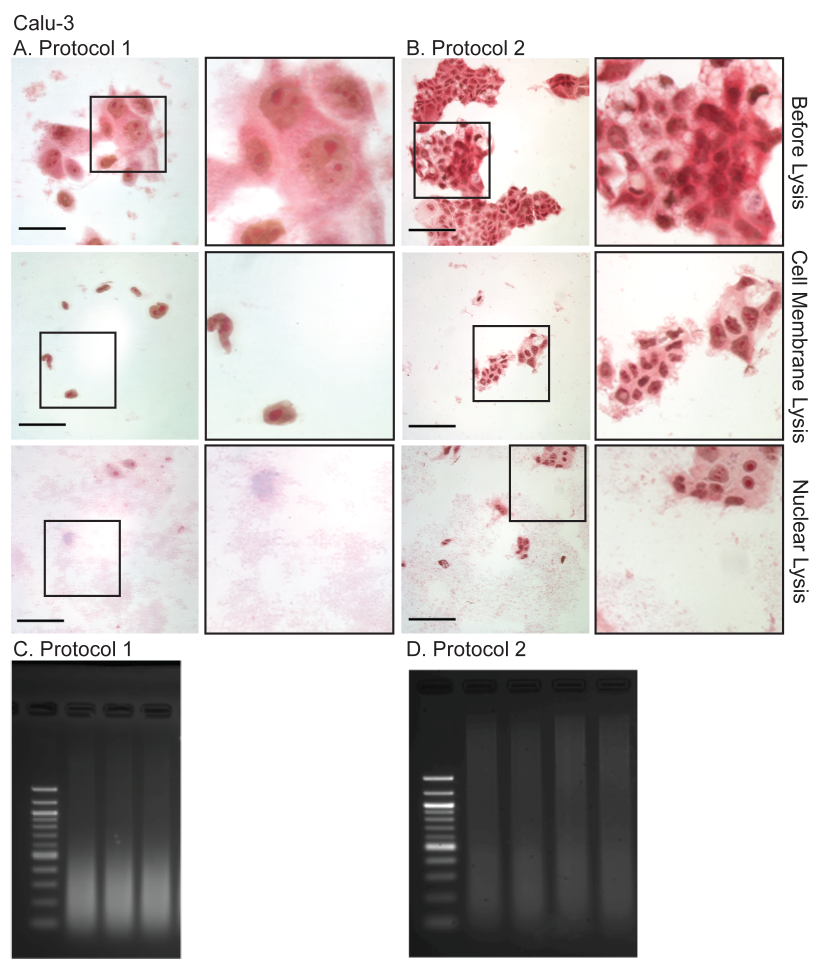
Figure 2. Light microscopy of the Methyl Green-Pyronin stained human airway epithelial cell line, Calu-3 during the modified (A, Protocol 1) and unmodified (B, Protocol 2) and resulting sonicated chromatin (C, D), separated on 2% agarose gels post-stained with 0.01% ethidium bromide. Note, the sheets of cells have not lysed during protocol 2 and the resulting sheared DNA is of poor quality for ChIP. Methods as described in the text. Scale bar=50 m m for A (Protocol 1) and 100 m m for B (Protocol 2).